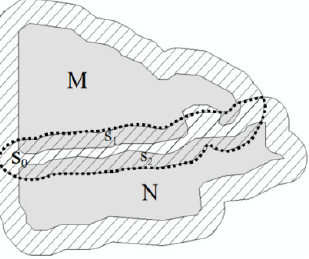
Figure 5. Schematic diagram of overlapping buffer areas between parcels.